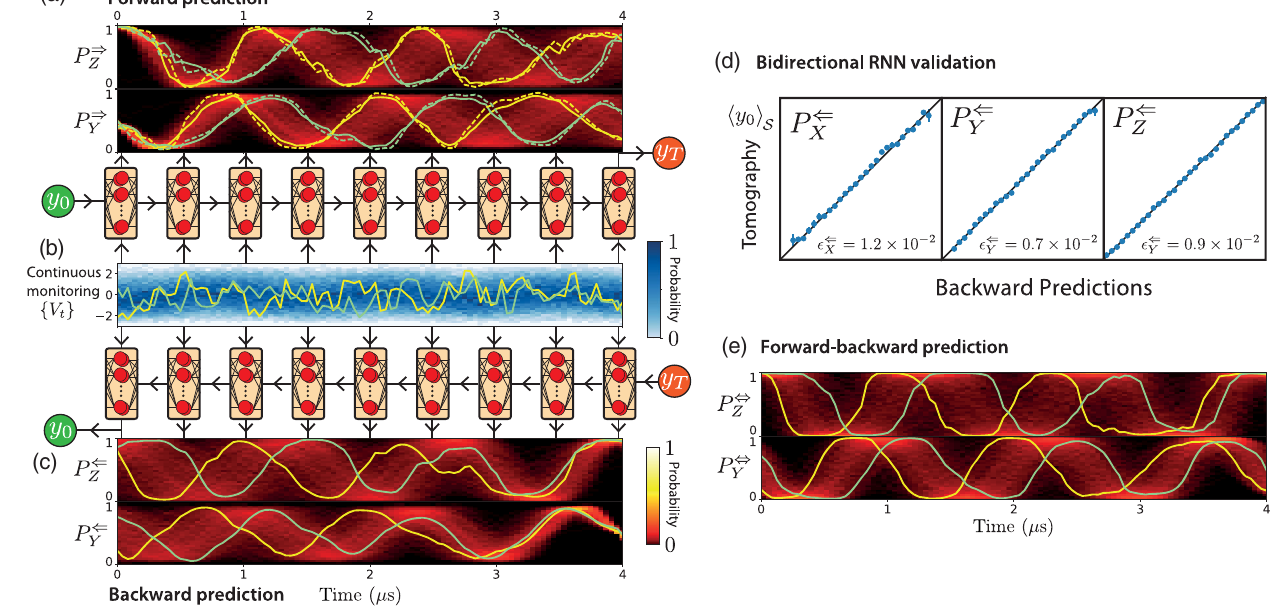
FIG. 3. RNN prediction and retrodiction of the quantum evolution. (a) Red-scale histograms of the RNN prediction for the measurement basis b ¼ Y and Z in the driven case beginning from y 0 ¼ 1 in the preparation basis a ¼ Z . Traces plotted in color show the two representative predictions from the measurement records by the RNN (plain line) and by the stochastic master equation (dashed line). (b) Blue-scale histogram of the normalized measurement records extracted from the experiment; traces plotted in color show representative instances. (c) Red-scale histograms of the RNN retrodiction for the same measurement record. Traces plotted in color show the two representative retrodictions from the measurement records by the RNN. (d) Retrodiction validation: Comparison of the RNN backward prediction with the tomography. The tomography h y 0 i S ( y axis) is given by the initial projective measurement outcome along X , Y , and Z quadratures averaged over the subset of trajectories S p leading to the prediction p ( x axis). The blue dots correspond to the RNN predictions. The average errors ϵ ⇐ X;Y;Z shown in the plots are used to quantify the agreements between the prediction and the tomography; it is calculated based on the method explained in the validation section of the main text. (e) Red-scale histograms of smoothed RNN predictions based on the forward-backward analysis given by Eq. (5) for the same measurement